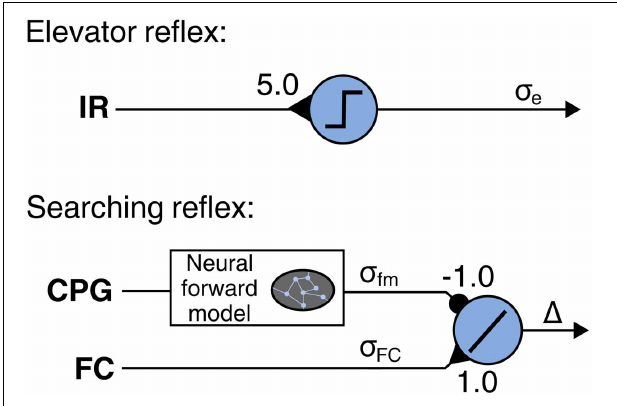
FIGURE 7 | Neural modules for local leg reflexes: searching and elevator reflex. A neural forward model is applied to determine expected foot contact signal from leg motor pattern provided by the CPG. The additive neuron accumulates positive errors which cause vertical shifting of the CTr and FTi signals, resulting in searching reflex. A preprocessed infrared reflex signal are fed into a neuron using a linear threshold transfer function. The threshold is set to 0.01. The output signal σ e shifts the CTr and FTi signals upwards. As a result, the leg is elevated. Note that each leg has its own searching and elevator reflex